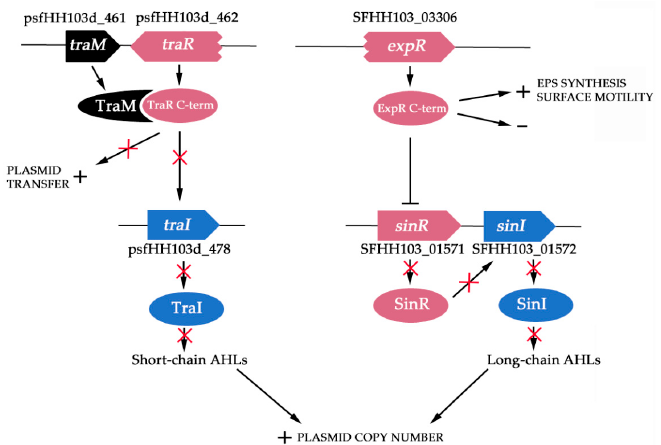
Figure 3. Hypothetic model of transcriptional regulation of quorum sensing (QS) in Sinorhizobium fredii HH103. Putative regulation of the tra and sin systems is shown. TraM binds to TraR C-term